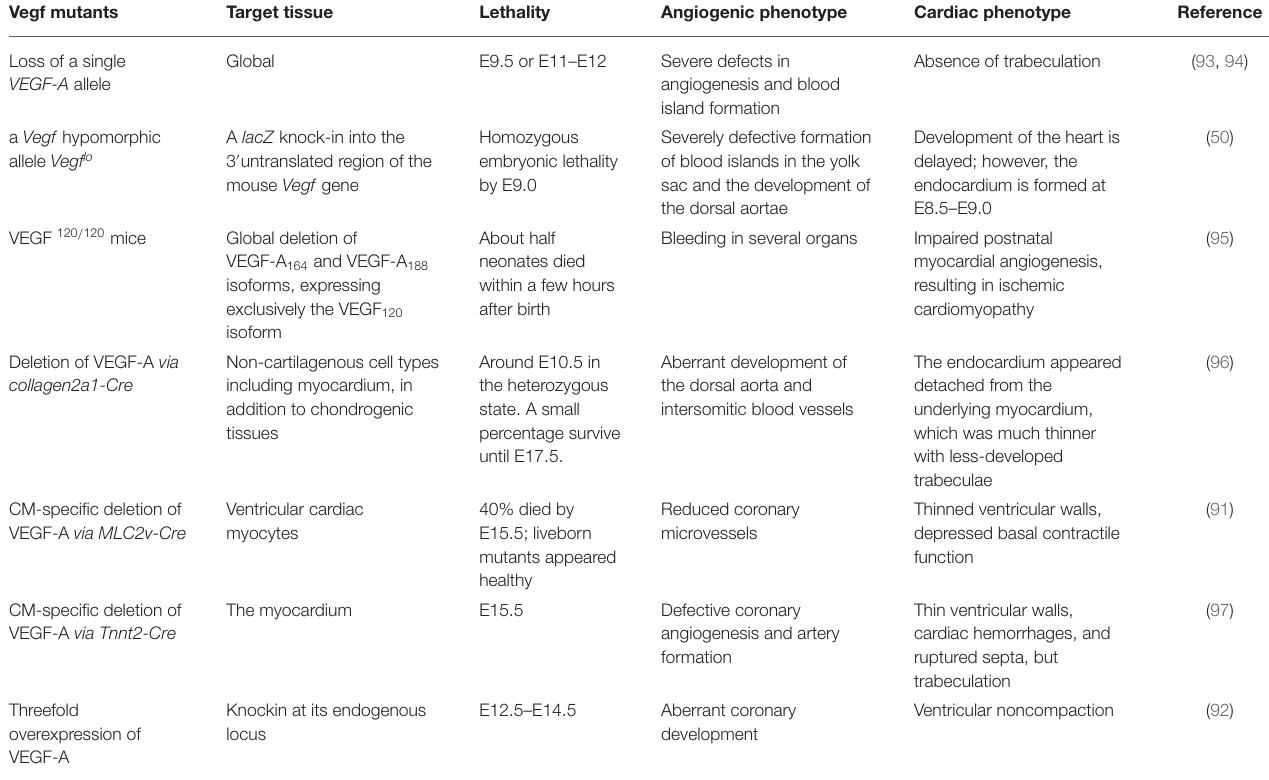
TABLE 1 | Vegf-a mutant models and their